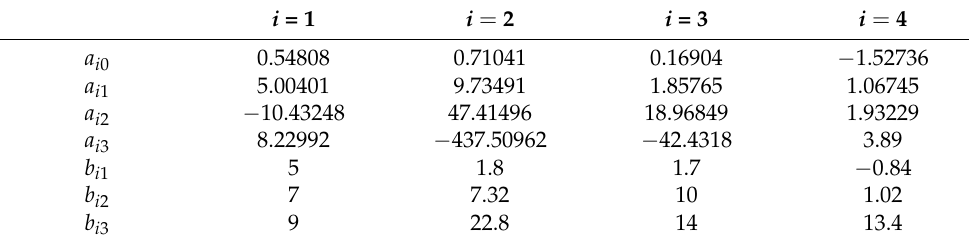
Table 1. Fitting coefficients in Equation (8).